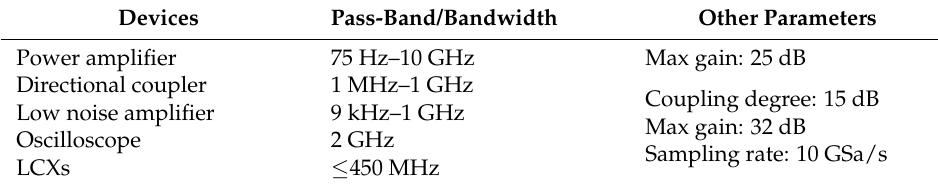
Figure 1. Experimental setup of the LCX sensor utilizing a wideband chaotic signal. Table 1. The main parameters of the devices used in our proposed LCX sensor.